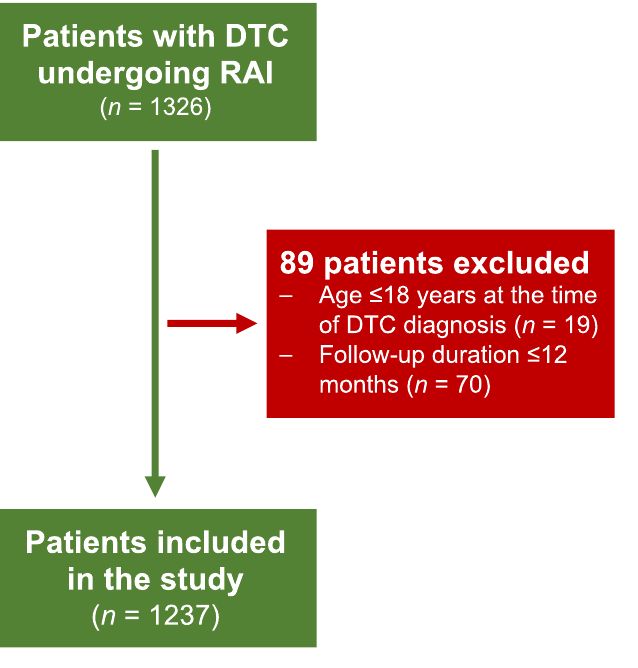
Figure 1. Studied population. Table 1. Clinical characteristics in the overall patient population according to SPM